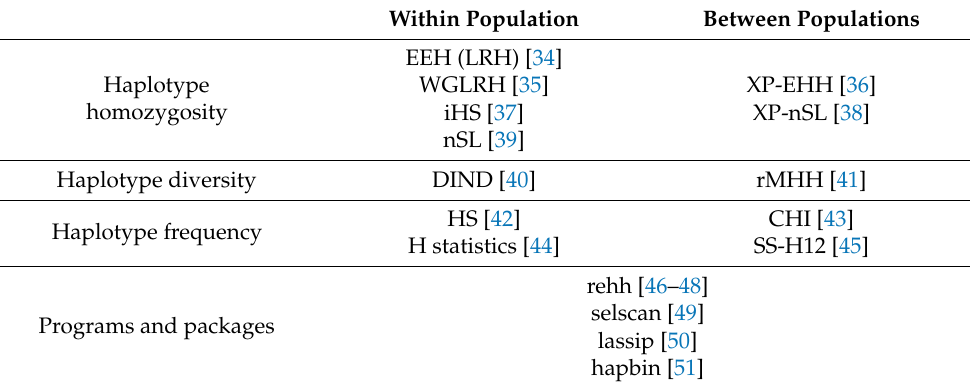
Table 1. List of popular methods, algorithms, statistics, and packages for detecting haplotype-based signatures of positive selection in population-wide sequencing data. EEH: extended haplotype homozygosity; LRH: long-range haplotype; iHS: integrated haplotype score; nSL: number of seg- regating sites by length; XP-EHH: cross-population extended haplotype homozygosity; XP-nSL: cross-population number of segregating sites by length; DIND: derived intra-allelic haplotype di- versity; rMHH: ratio of most frequent haplotype homozygosity; HS: haplosimilarity score; CHI: comparative haplotype identity; SS-H12: H statistic for shared selection; REHH: R package for extended haplotype homozygosity-based test computation. Within Population Between Populations